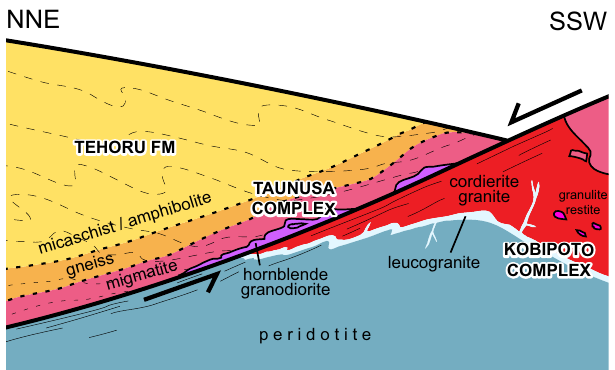
Fig. 21b. Enlargement of part (a) showing more detailed field rela- tions (schematic) in the detachment zone, as observed on the Kai- bobo and Hoamoal